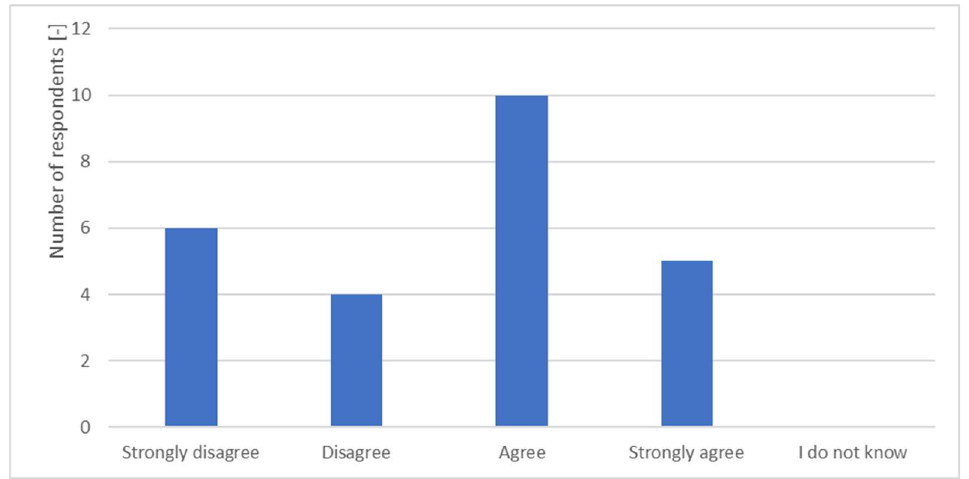
Figure 16. The link between open shared mobility systems and service development.